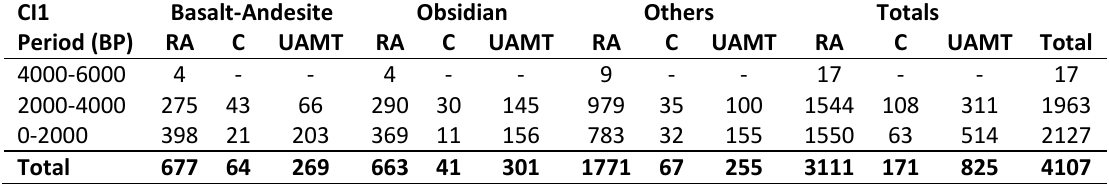
Table 3. Cerro de los Indios 1 (CI1) lithic assemblages by period. RA: Retouched artefact; C: core; UAMT: Unretouched artefact with marginal traces. CI1 Basalt-Andesite Obsidian Others Totals Period